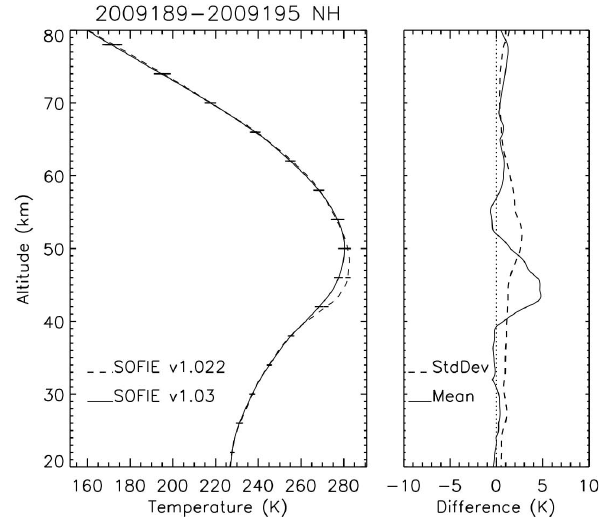
Fig. 27. SOFIE version 1.03 data compared to version 1.022 for the period 8–14 July 2009. Note the difference in the 40–50km region. Right-hand panel shows the mean difference and difference standard